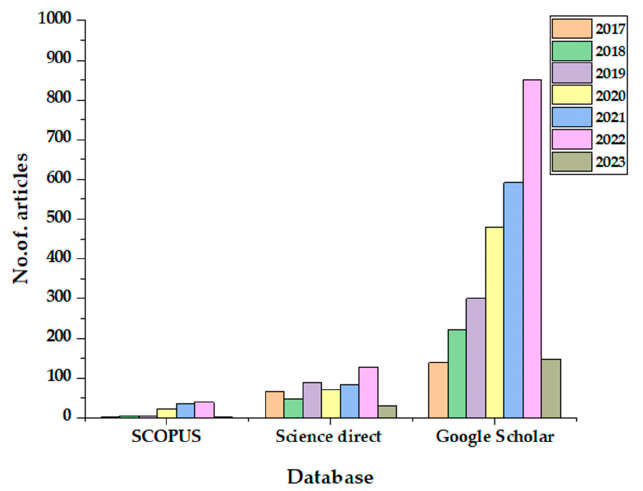
Figure 1. Trends in Py/GC-MS based co-pyrolysis studies in various databases.